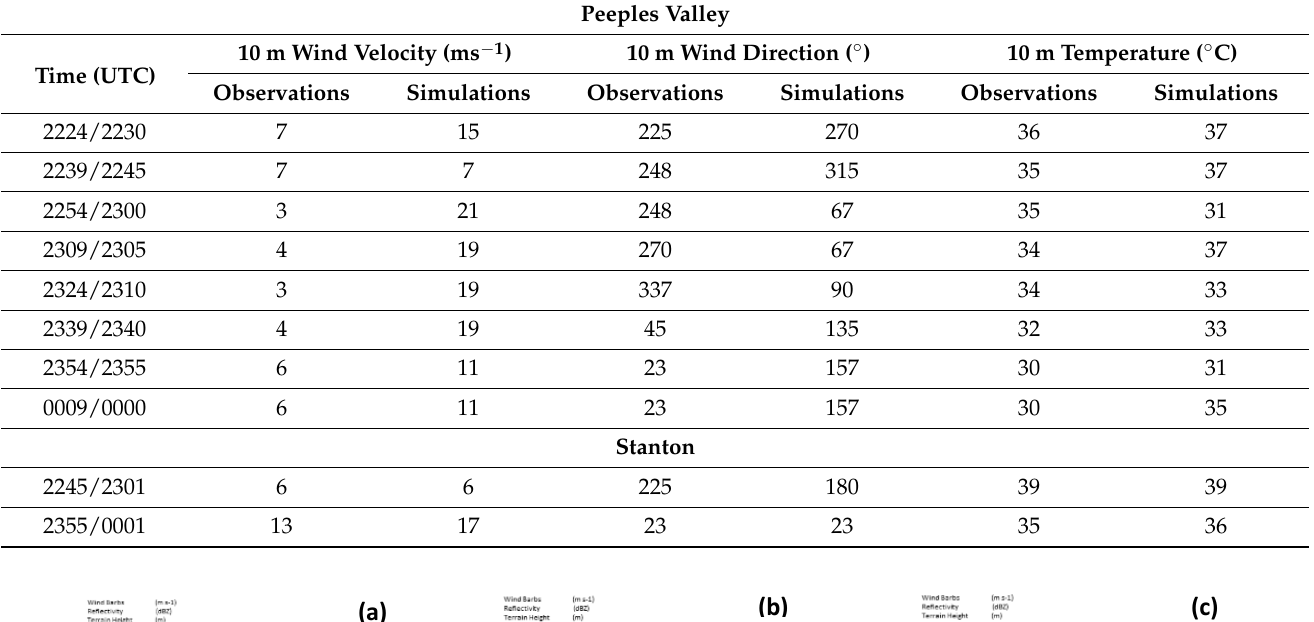
Table 2. Comparison between 259 m simulated 10 m wind velocity, wind direction, and temperature at Peeples Valley and Stanton and the RAWS at the same locations.